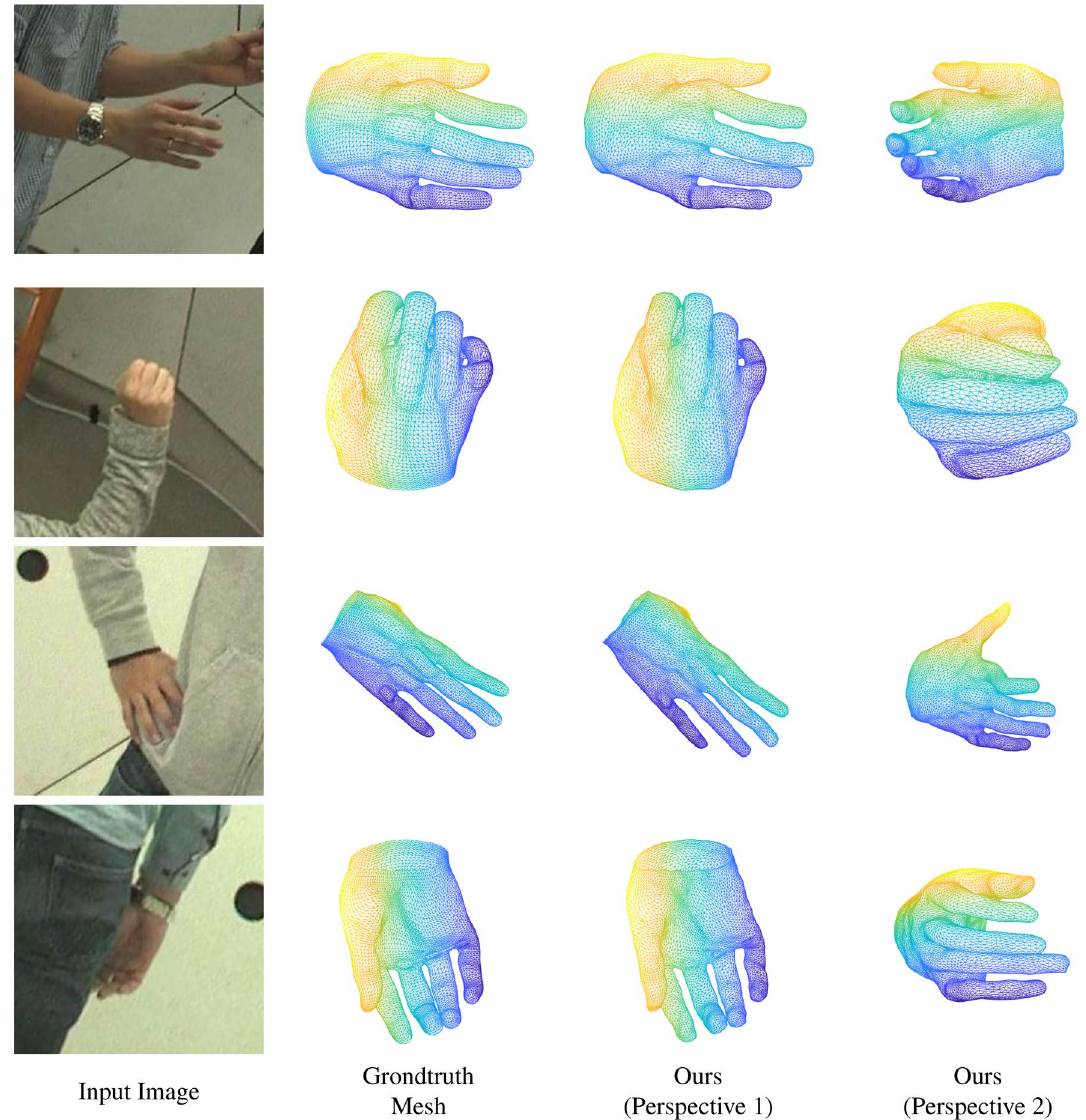
Figure 6. The qualitative results obtained for the Dome dataset 15 . The meshes in the dataset contain 7907